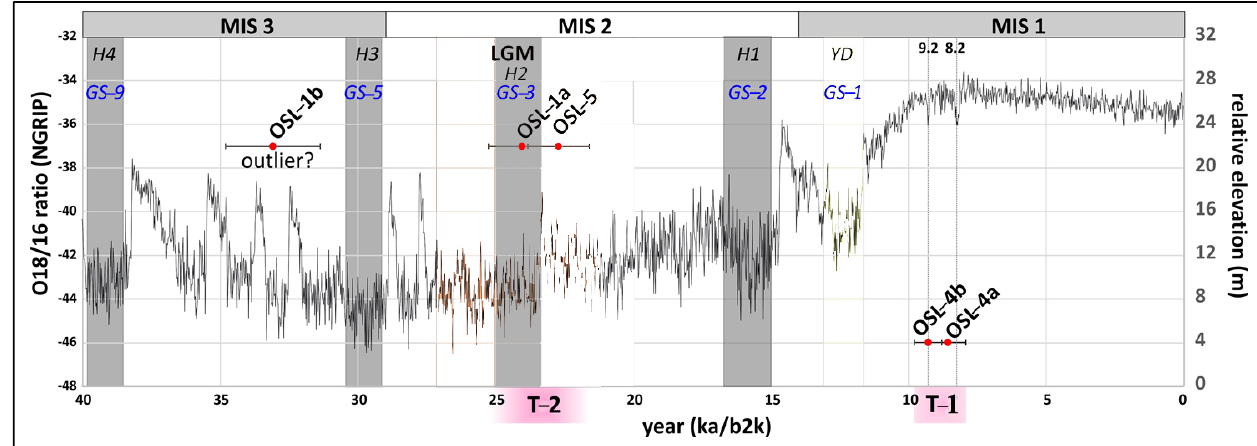
Figure 7. The present-day Murat River.